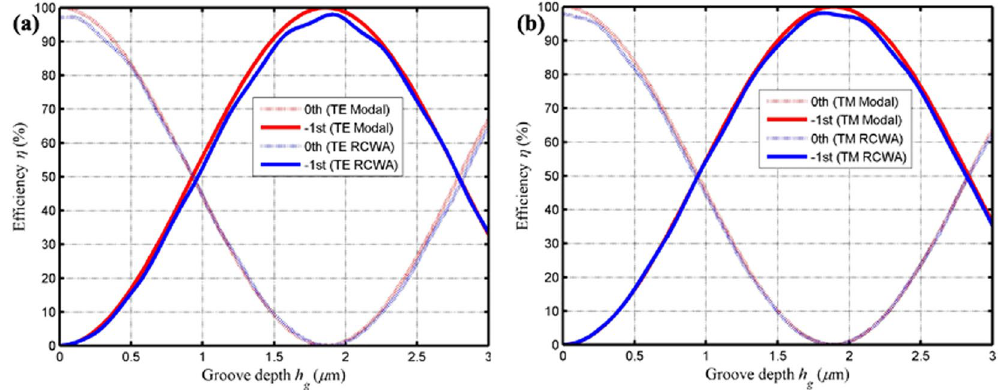
Figure 4. Diffraction efficiency versus groove depth in the 0th and the − 1st orders based on simplified modal method and RCWA: ( a ) TE-polarized light and ( b ) TM-polarized